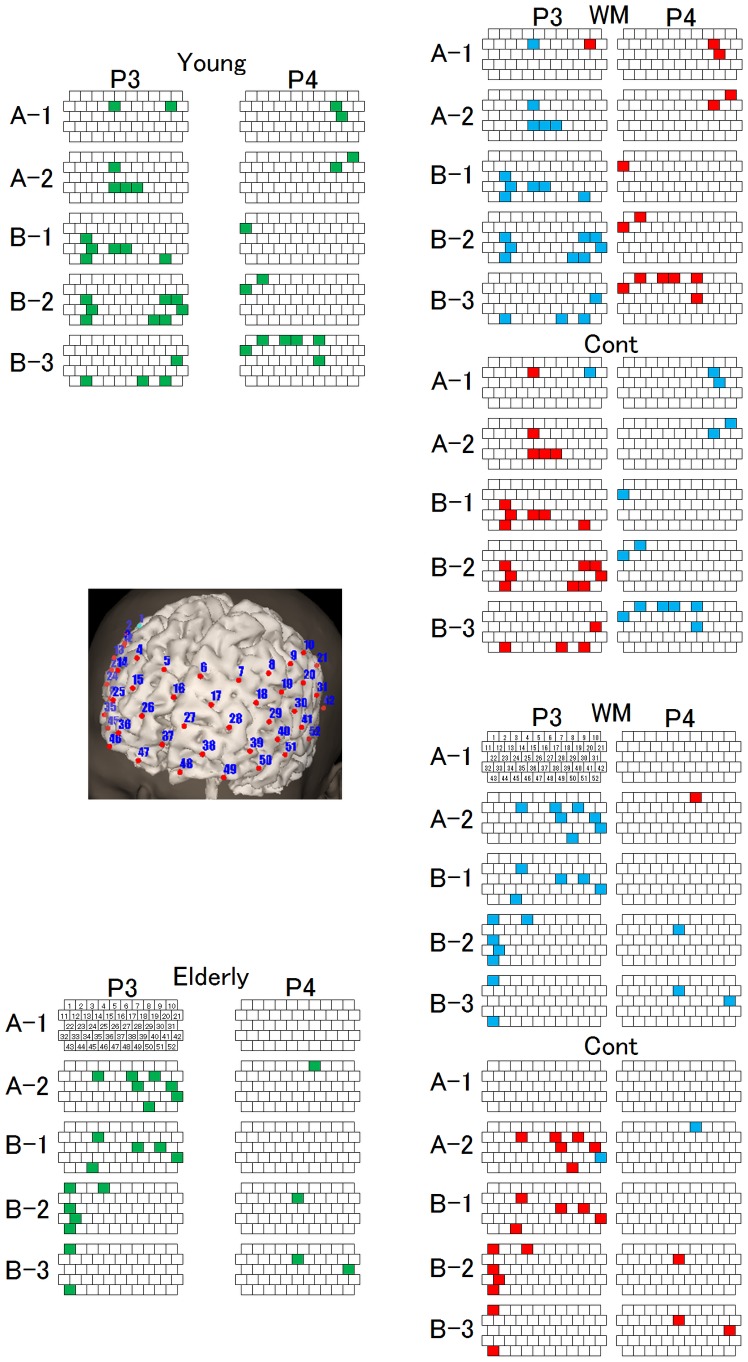
Distribution of significant P values mapped on the NIRS channels with time segments.The results of a two-way (Task × TMS) ANOVA for oxy-Hb conducted for each TMS site, 52 channels, and time segment are shown for both the young and the elderly participants. The channels for which the Task × TMS interaction effect was significant are shown. The green channels indicate a location where the P value <0.05. The red channels indicate channels for which the oxy-Hb was increased, and the blue channels indicate channels for which the oxy-Hb was decreased. Notice that almost no significant channels for the elderly P4 TMS condition are present for all the segments.